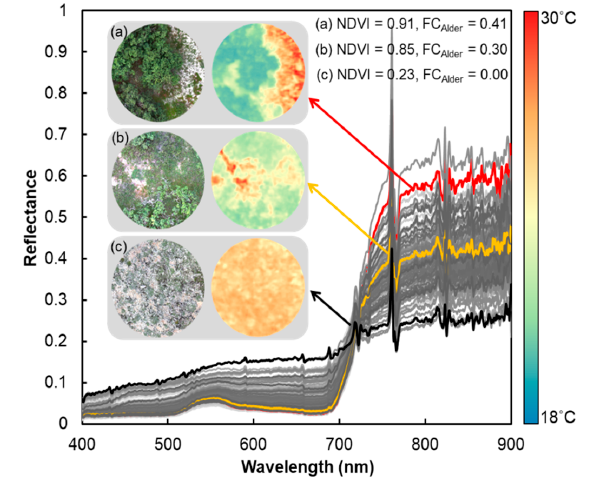
Figure 7. Osprey -collected spectral reflectance data from the case flight at the Kougarok Hillslope field site. The inserted three subplots ( a ), ( b ), and ( c ) show the RGB and TIR footprints of three spectral measurements with different fractional covers of Siberian alder. NDVI is the normalized difference vegetation index (NDVI) of the three subplots, and FC Alder is the fractional cover of Siberian alder.